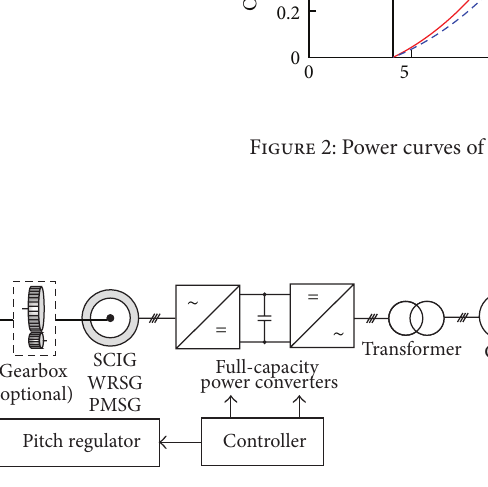
Figure 3: Configuration of a typical WECS (with full-capacity power